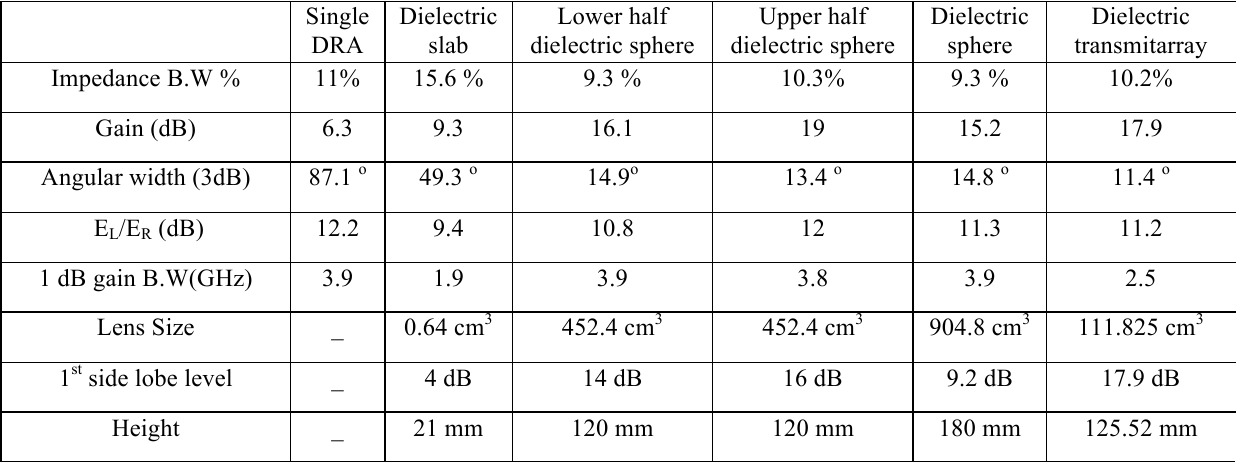
Table 2: Comparison between different enhanced radiation characteristic for the DRA element loaded with different types of